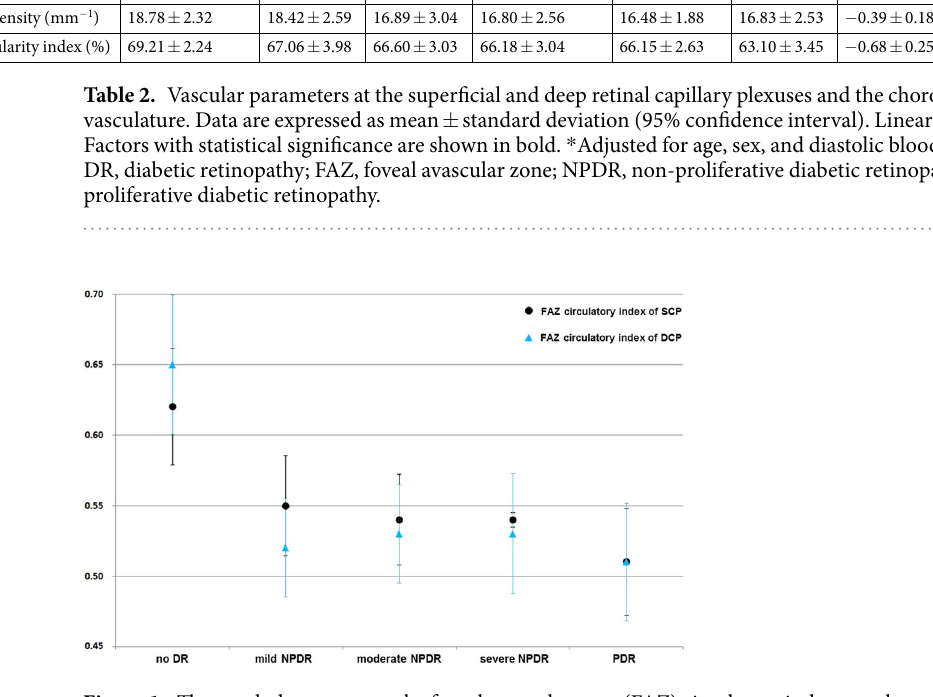
Figure 1. The graph demonstrates the foveal avascular zone (FAZ) circulatory indexes at the superficial capillary plexus (SCP) and deep capillary plexus (DCP) in diabetic patients. In the early stages of diabetic retinopathy (DR), the decreasing trend of the FAZ circulatory index is remarkable at the DCP. Notes: DR, diabetic retinopathy; NPDR, non-proliferative diabetic retinopathy; PDR, proliferative diabetic